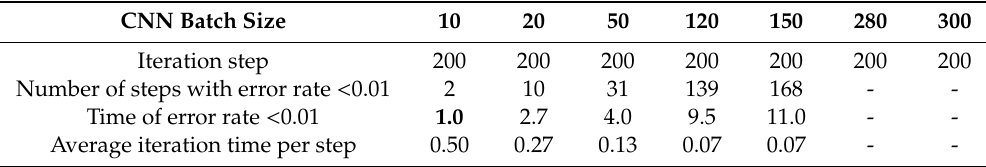
Table 9. Convergence of F–R CNN model in di ff erent number of batch training samples. F-R CNN Batch Size